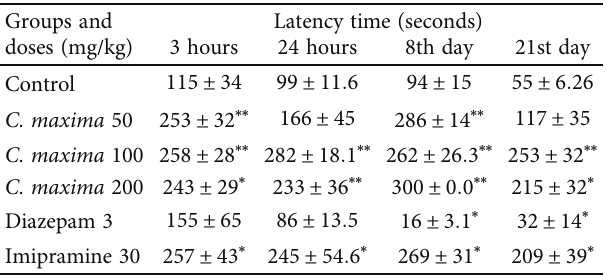
Table 2: Outcome of C. maxima seeds on memory by passive avoidance.